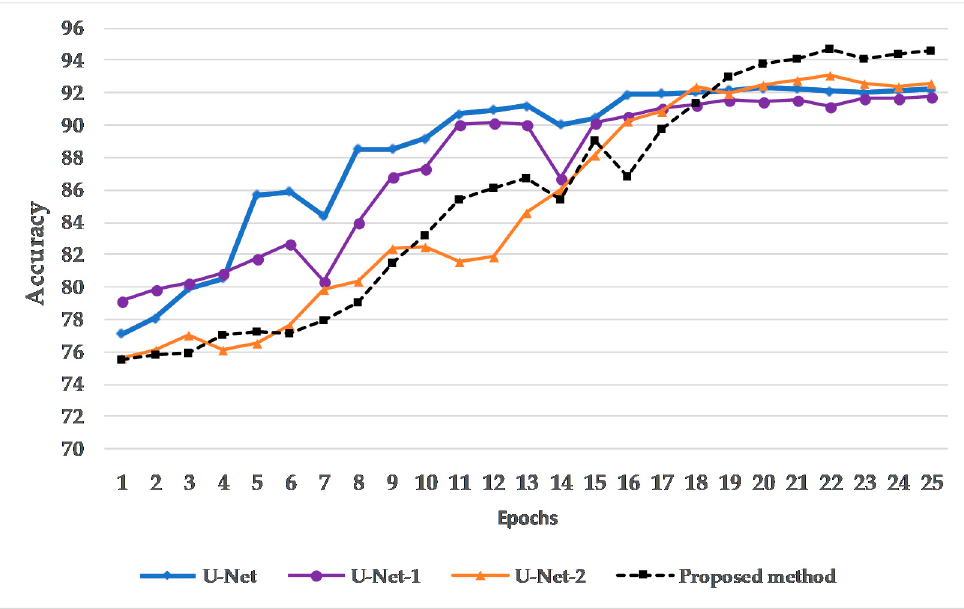
Figure 11. Comparing learning curves per epoch.